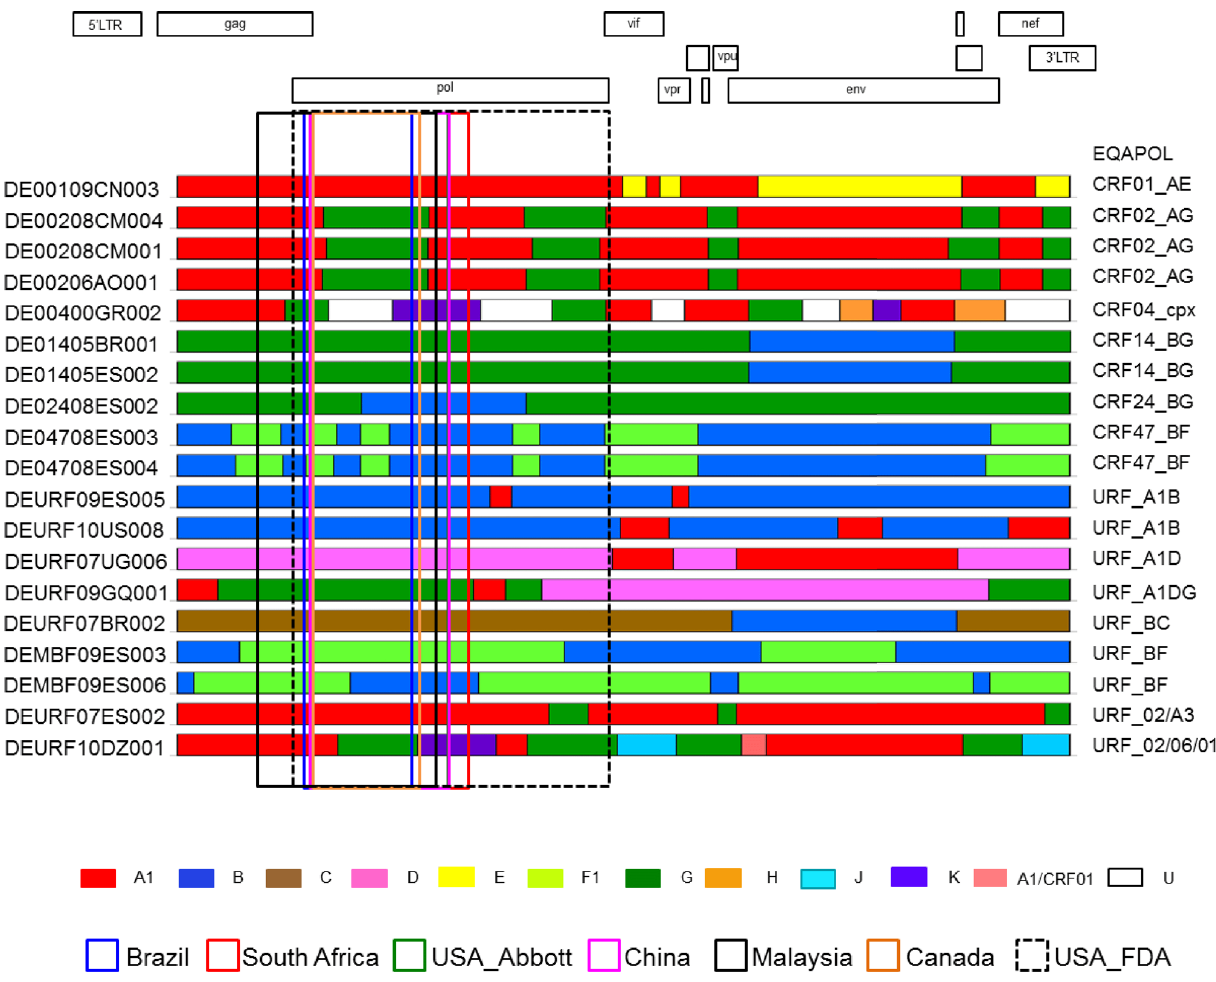
Fig 3. Recombination patterns in the pol gene and the near full length genome. The recombination patterns of near full-length sequences determined at EQAPOL are shown and indicated on the far right. The pol gene region amplified at each site is indicated by the colored box. Subtypes are color coded (shown at the bottom).